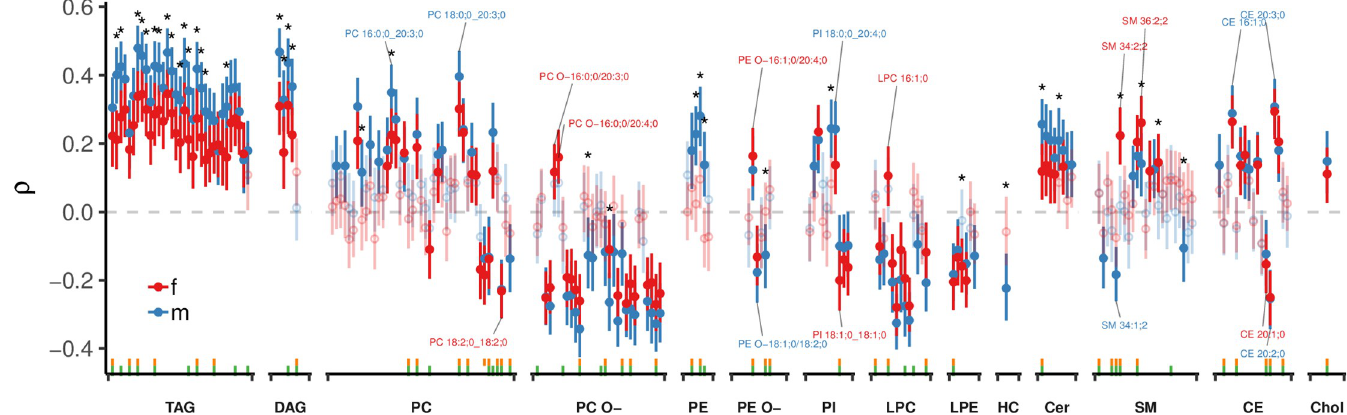
Fig 4. Correlation of lipid subspecies with BFP. Spearman correlation coefficients ( ρ ) and their 95% CI for each sex (male and female) and adjusted for subject age are shown for lipid subspecies. HC signifies the HexCer lipid class. Green ticks at the bottom indicate subspecies used in the model with the lowest MAE ( n = 58), whereas yellow ticks indicate the model within 1 standard error from the lowest MAE ( n = 45, S4 Fig). Correlations with Benjamini-Hochberg corrected p < 0.05 are shown with filled points, whereas correlations with p > 0.05 are shown with open circles and transparently. Differences between male and female correlations were compared and significant differences are indicated by an asterisk ( � ). A total number of 202 lipid subspecies were tested in 1,005 subjects, of those, 53.5% (108) were significantly correlated with BFP in females and 65.3% (132) in males. Some lipid subspecies of interest have been labeled. Additional correlations are shown in Fig S12 and correlation data is provided in S11 Table. BFP, body fat percentage; CI, confidence interval; MAE, mean absolute error.